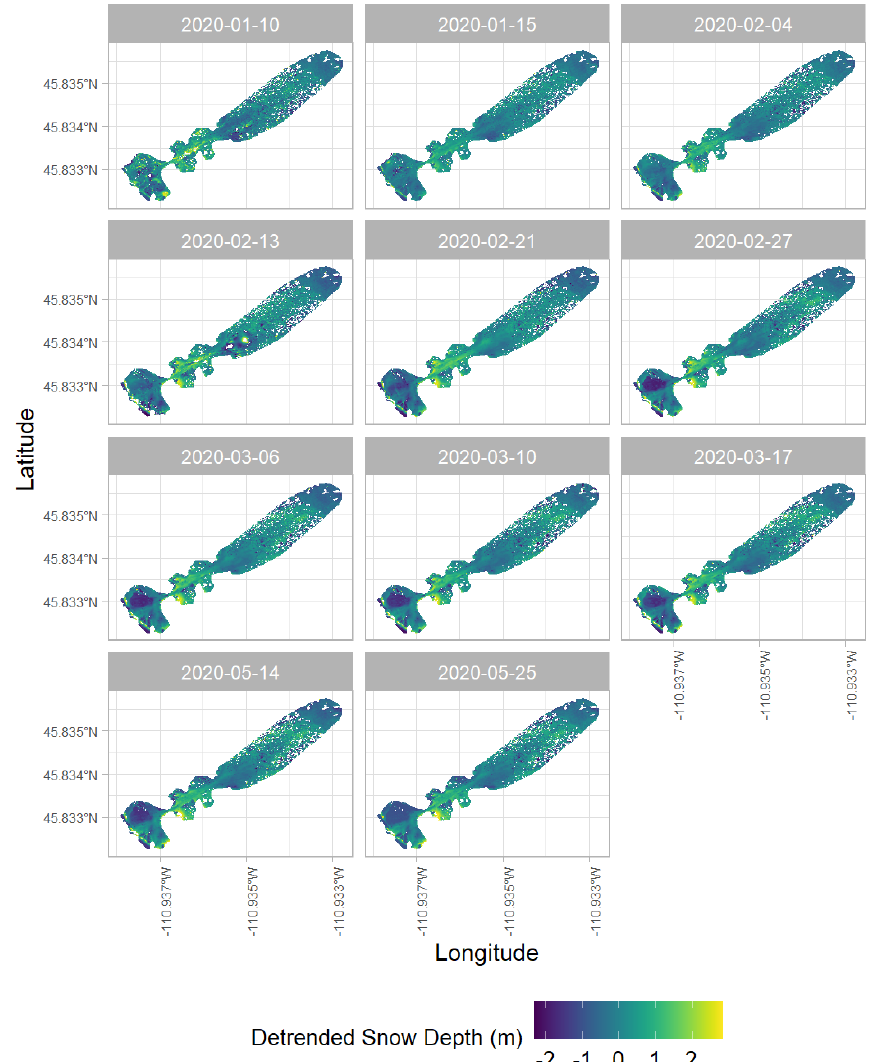
Figure A7. Time series of detrended snow depth maps of the Hourglass study site.